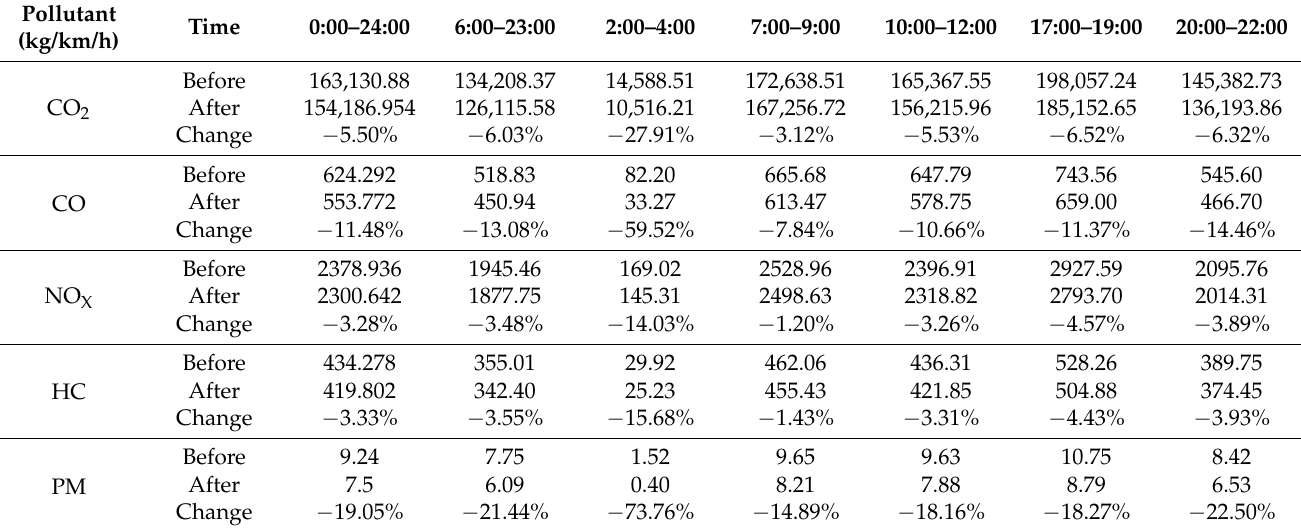
Table 8. The emissions intensity before and after the implementation of the traffic restriction policy in different